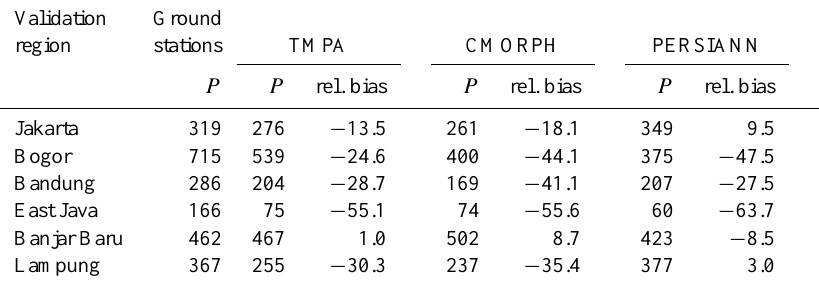
Fig. 4. Double mass curves showing the accumulated amount of rainfall of the observations against the satellite estimates (TMPA 3B42RT, CMORPH and PERSIANN) for each of the six validation areas for 2003–2008. Table 3. Average dry season (June–October) precipitation ( P , in mm) and relative bias (%) over the period 2003–2008 for ground stations, and satellite products TMPA 3B42RT, CMORPH and PERSIANN.